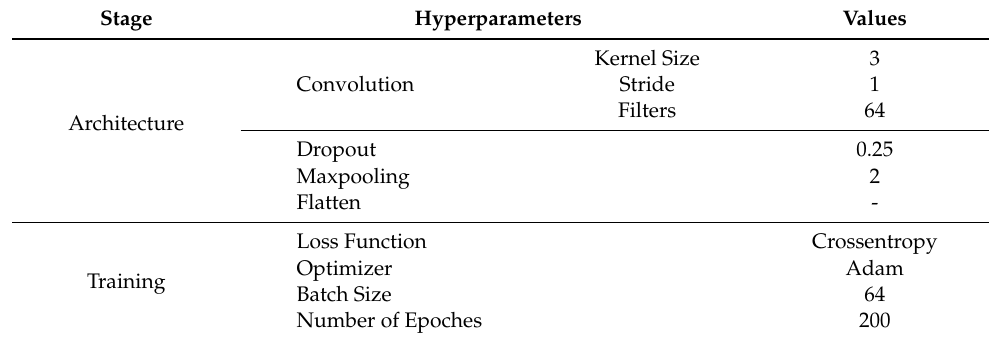
Table 5. The summary of hyperparameters for the CNN network used in this work.